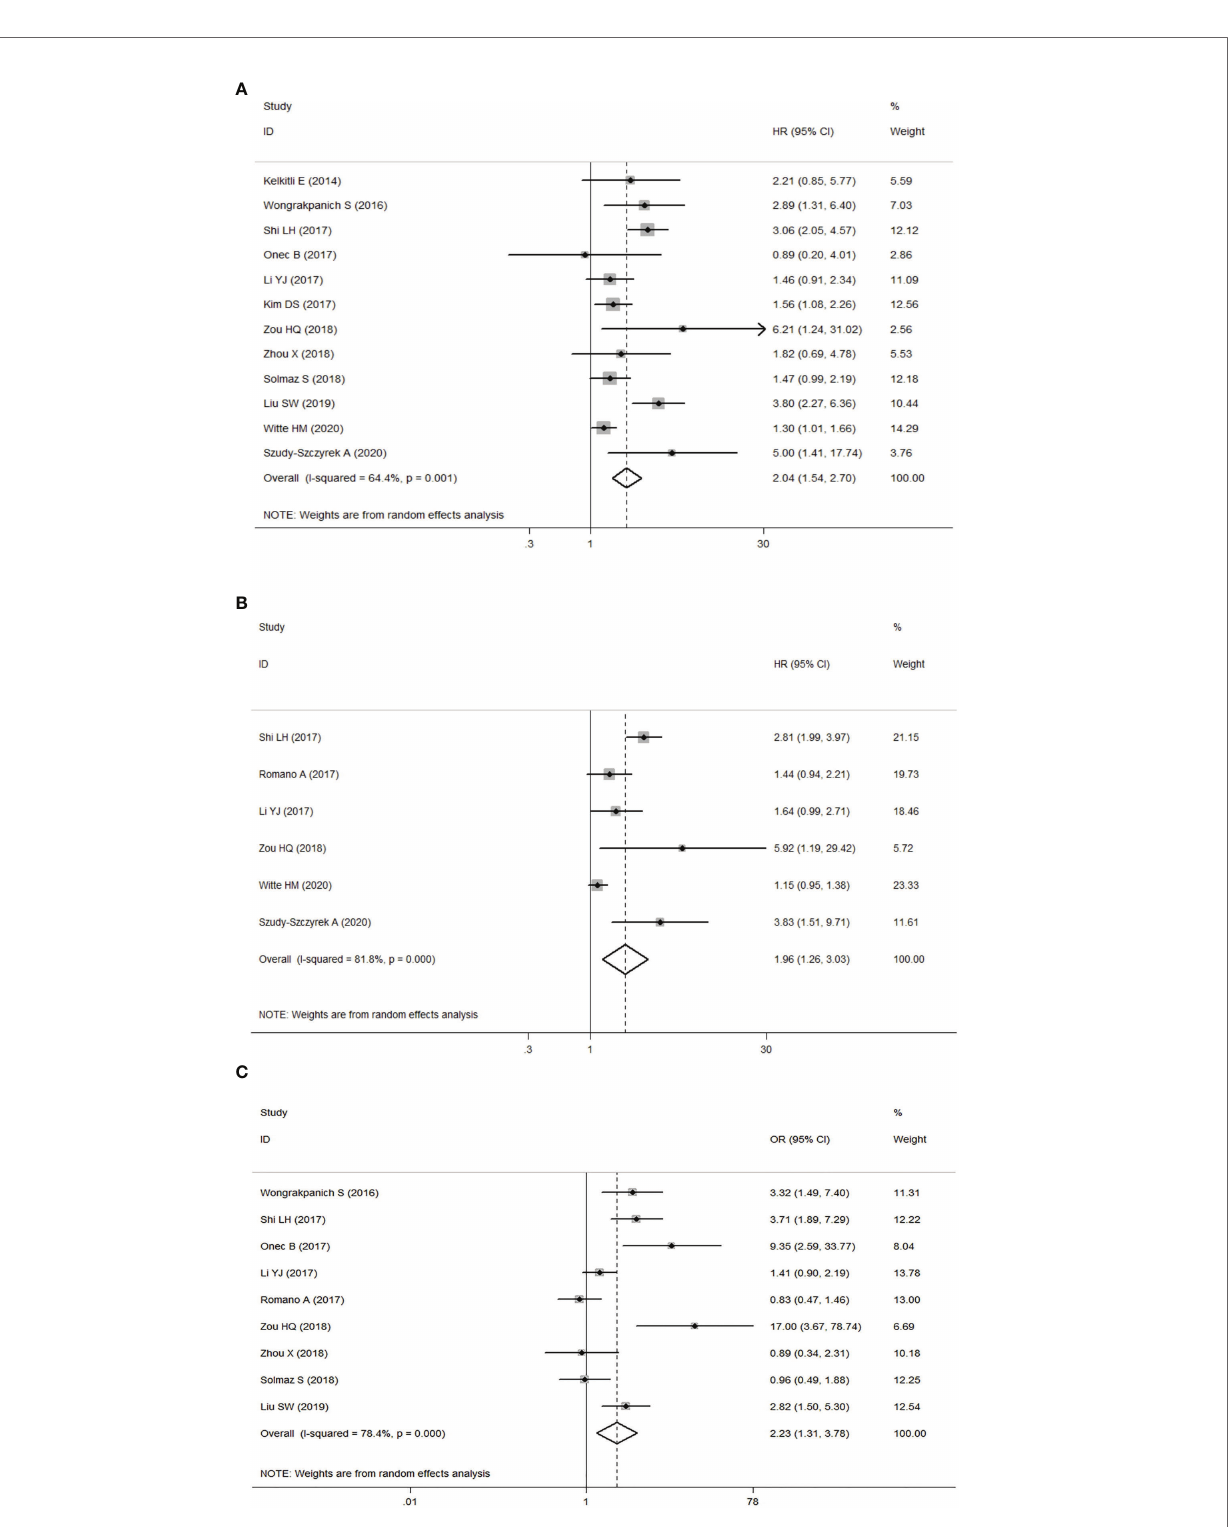
FIGURE 2 | Forest plot for the association between neutrophil-lymphocyte ratio (NLR) and OS (A) /PFS (B) of patients with multiple myeloma (MM). (C) Forest plots of the association between NLR and ISS